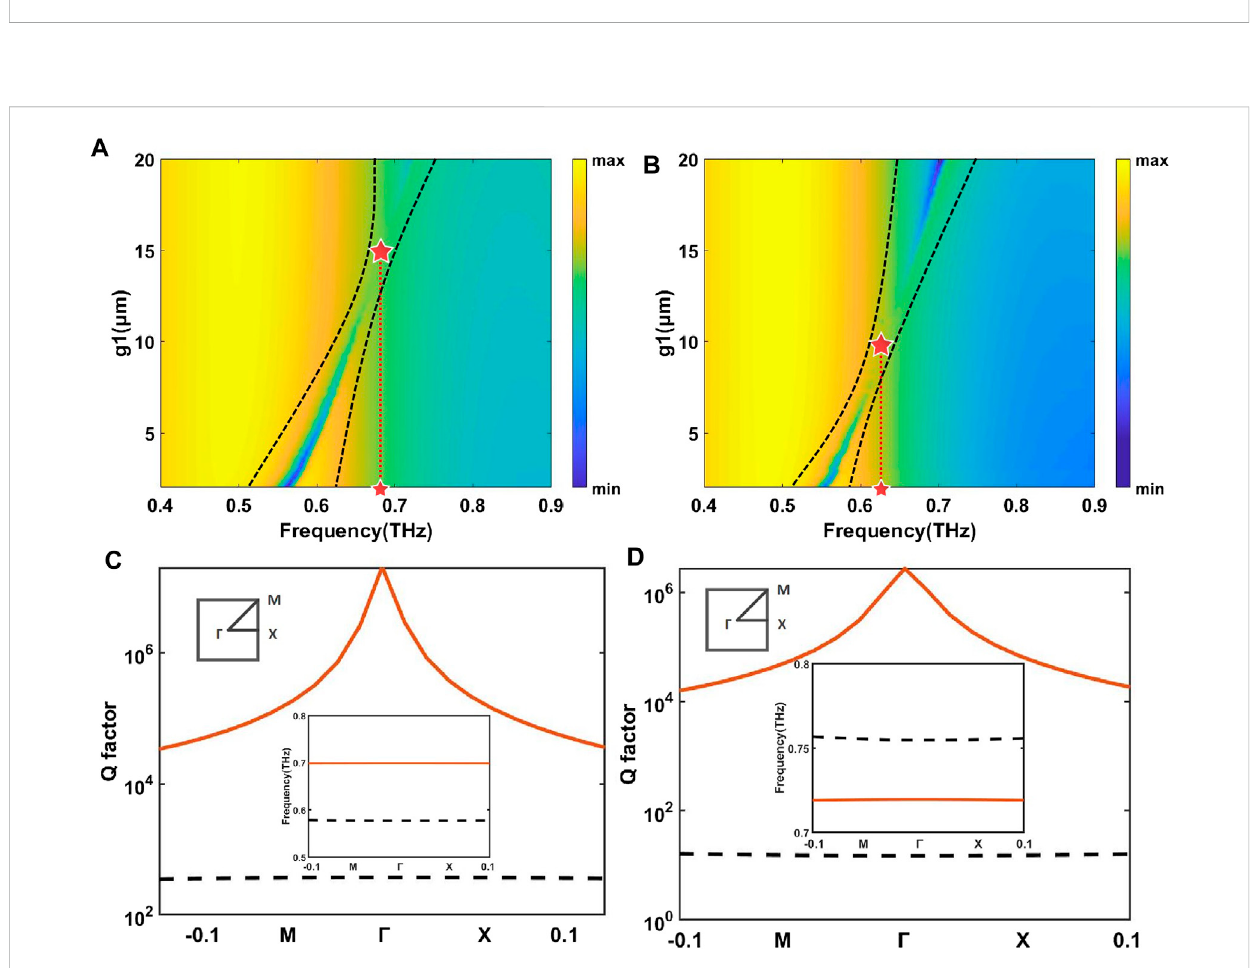
FIGURE 3 (A) The colour plot of the simulated transmission spectra of the BIC at low temperatures by scanning g 2 from 2 µm to 20 µm. (B) The colour plot of the simulated transmission spectra of the BIC at the high-temperature state by sweeping g 2 from 2 µm – 20 µm. (C) The Q factor and band structure correspondtothelow-temperatureBIC(inset)state. (D) TheQfactorandbandstructurecorrespondtothehigh-temperatureBIC(inset)state.Themetal lossisreduced,andtheimaginarypart ϵ ofthedielectricconstantisreducedto10 − 5 S / m .Thequasi-BICwestudyappearsatthe Γ pointinthe fi rstred Brillouin zone with an extremely high Q